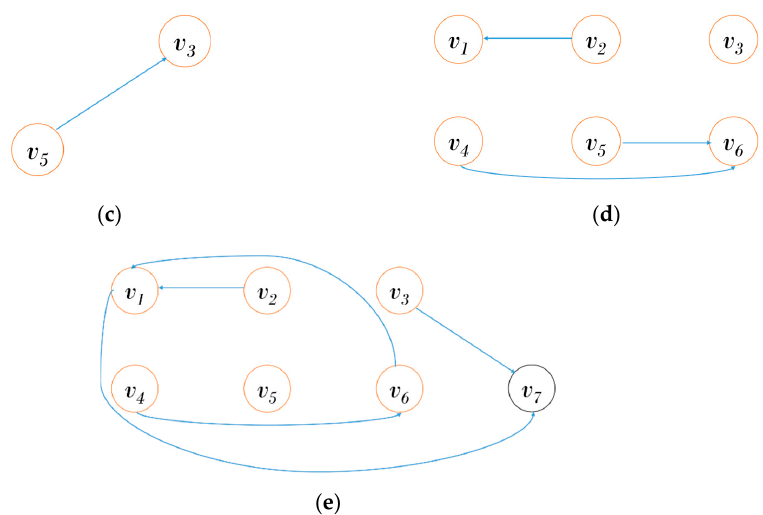
Figure 4. Generation of Delta Snapshot (DS): ( a ) Provenance graph; ( b ) Removing Common SubGraph (CSG); ( c ) DS 1 ; ( d ) DS 2 ; ( e ) DS 3 .